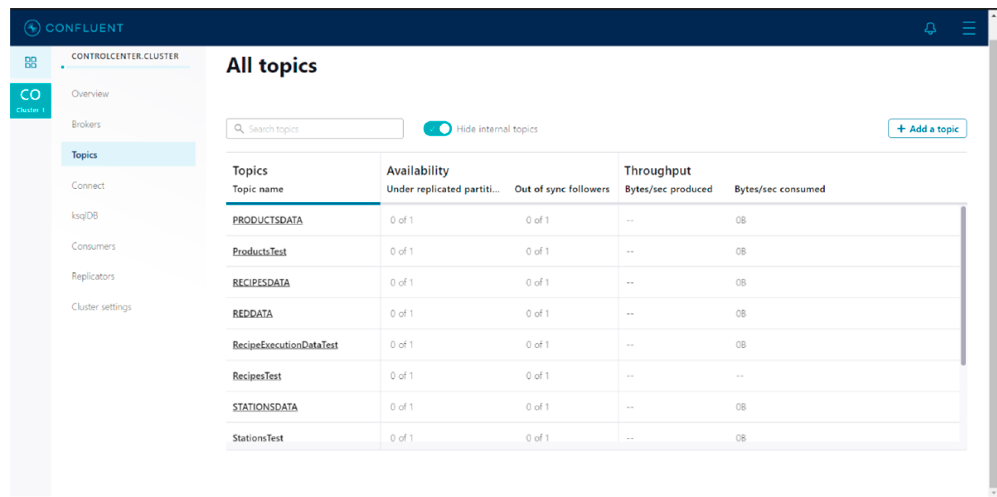
Figure 9. Overview of all created streams and their connections.